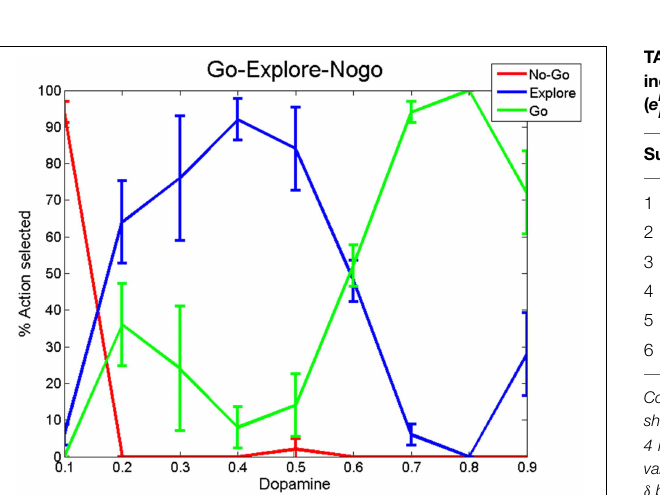
FIGURE 13 | Percentage of action selection observed in the Go, No-Go, and Explore regimes averaged over 200 trials with DP and IP weight values at w STN → GPi = 1.15 and w Str → GPi = 0.8. We ran the simulation for 100 trials and segmented in to 4 bins (25 trials each). We then calculated the variance of each regime across all DA levels.